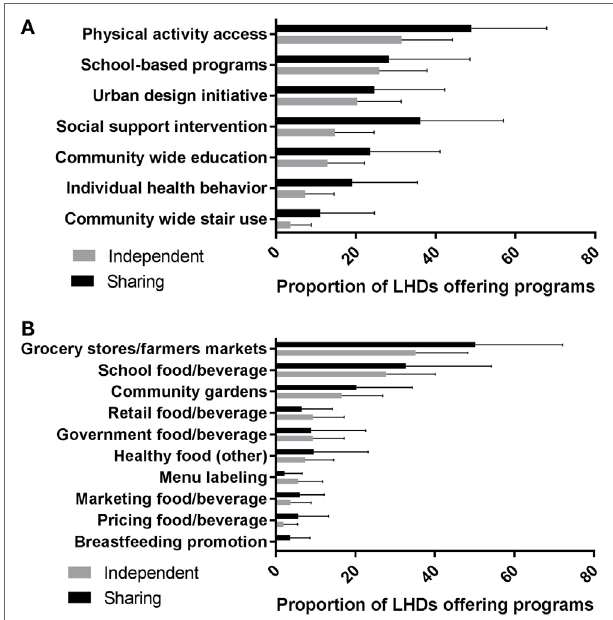
FigUre 1 | The proportion of communities were each approach to (a) physical activity interventions and (B) healthy food initiatives are available. Independent and resource-sharing values are for the proportion of the total number of participating municipalities were such activities are ongoing.